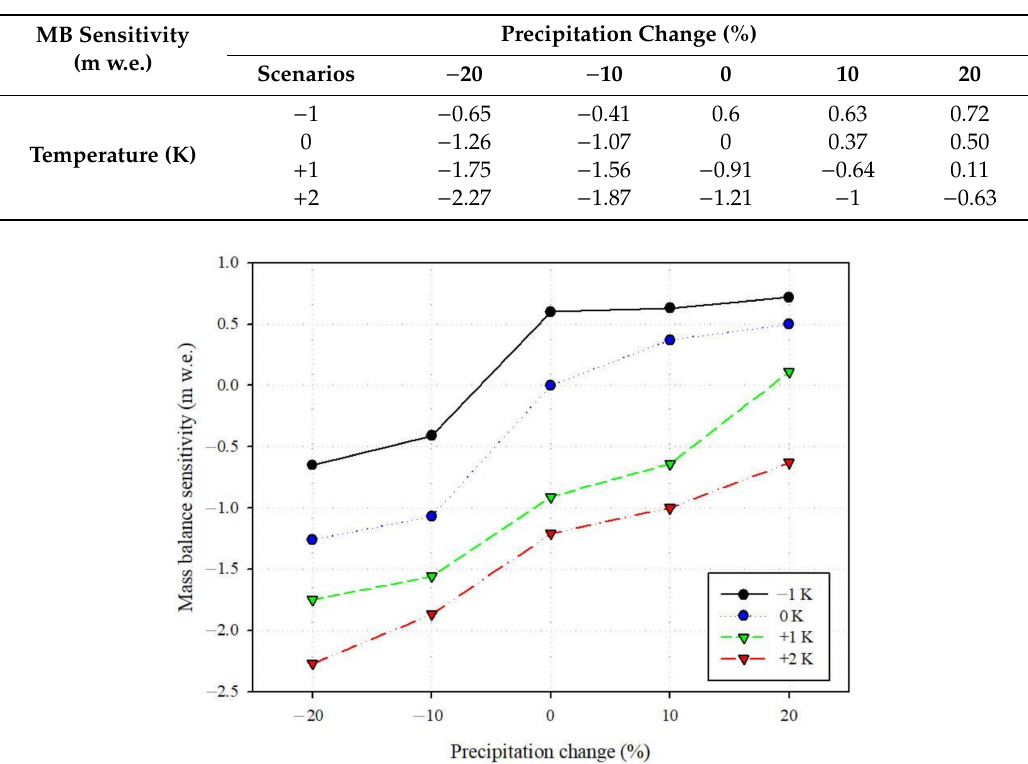
Table 5. Simulated changes of mass balance under di ff erent scenarios.